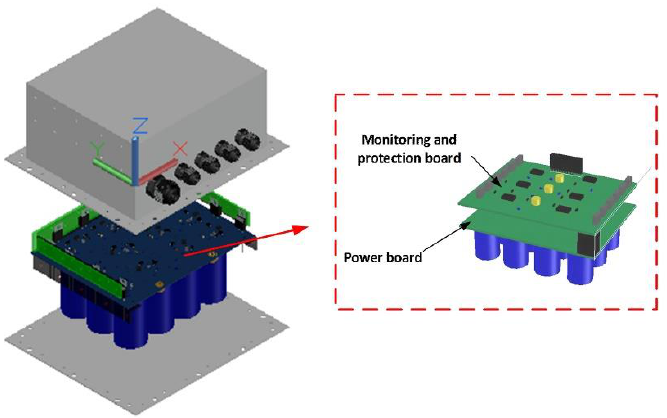
Figure 7. Assembly of one module as a part of the proposed SC-ESS.